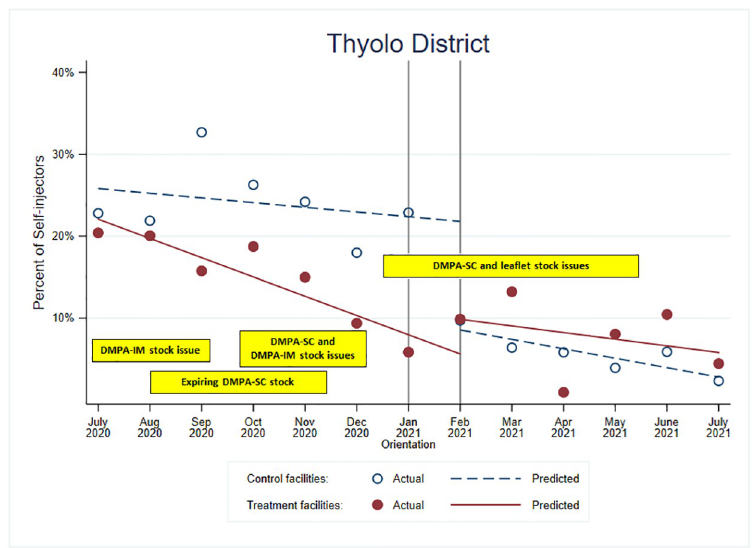
Fig 6. Percentage of total injections that were DMPA-SC self-injected and model-based trends for treatment and control facilities in Thyolo District, Malawi.